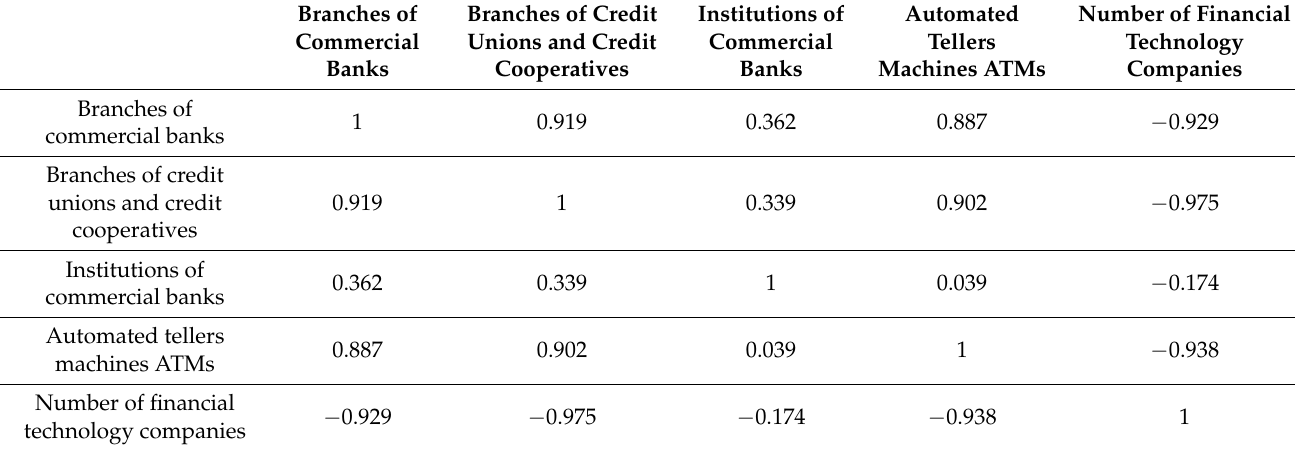
Table 2. Financial technology sector correlation with Financial Access Survey (FAS) indicators. (Composed by the au- thors according to Invest in Lithuania and IMF Survey numbers, 2020) (IMF Data Access to Macroeconomic & Financial Data 2020).